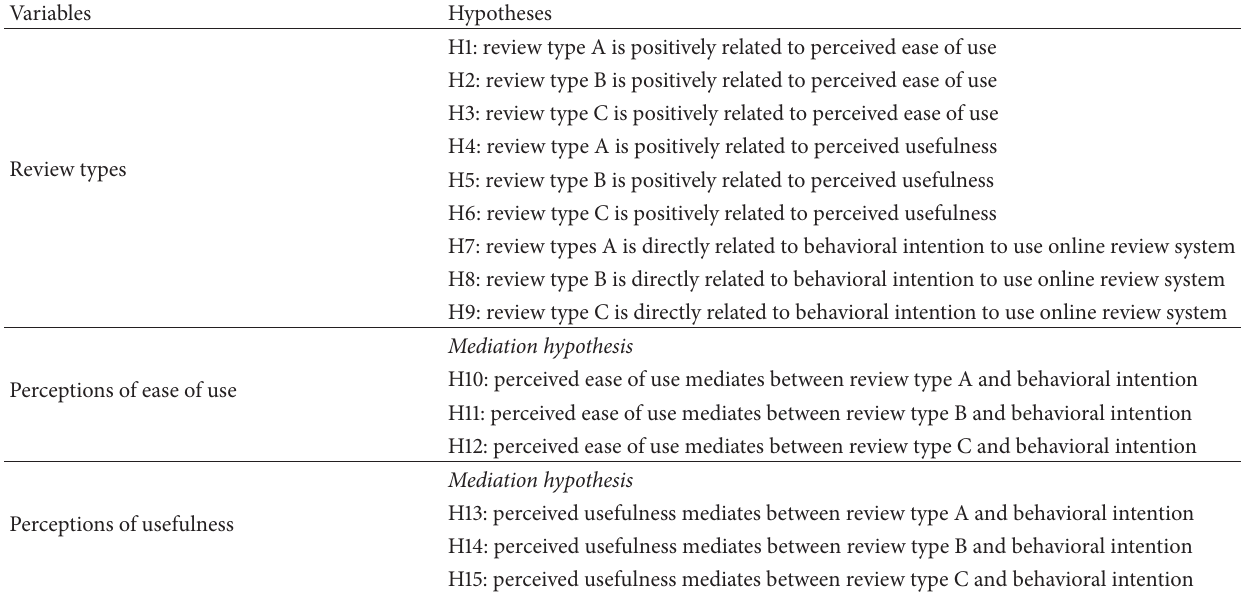
Table 1: Research hypotheses.